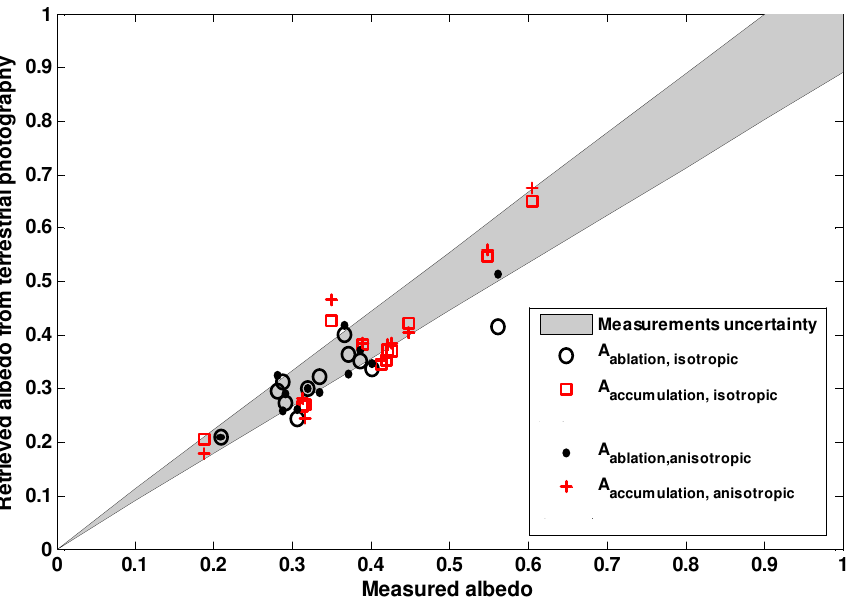
Fig. 5. Comparison between the albedo retrieved from terrestrial photography and the albedo measured by the AWS during the summer 2008. The gray area depicts the uncertainties of albedo measurements ( ± 10%). The squares and the circles correspond to the albedo estimated from the photographs while ignoring the anisotropic reflectance of snow and ice. The dots and crosses show the albedo estimated while modelling the